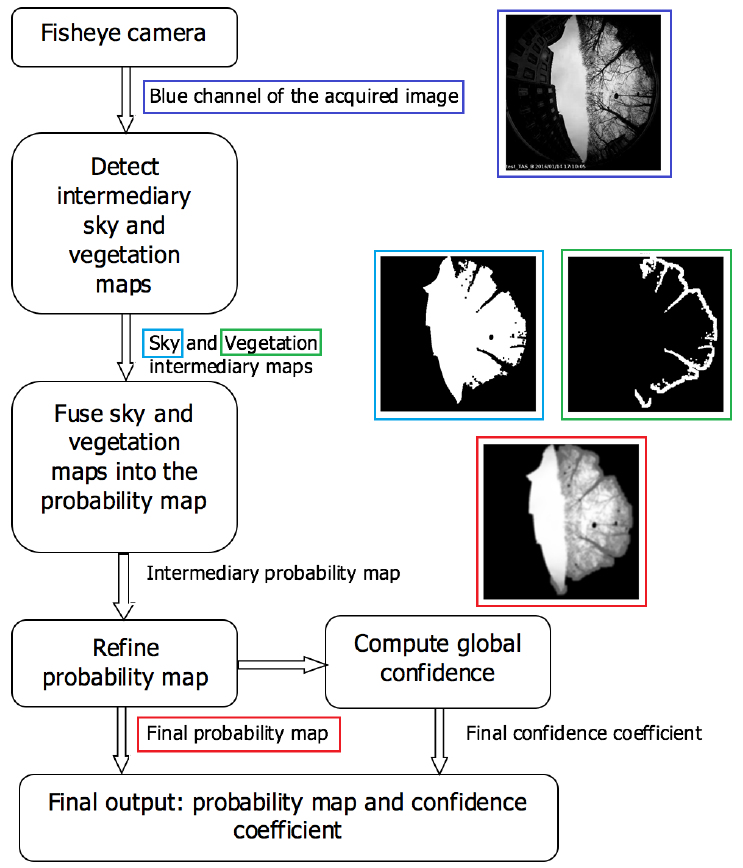
Figure 3. Block diagram of image processing module and an example of results.